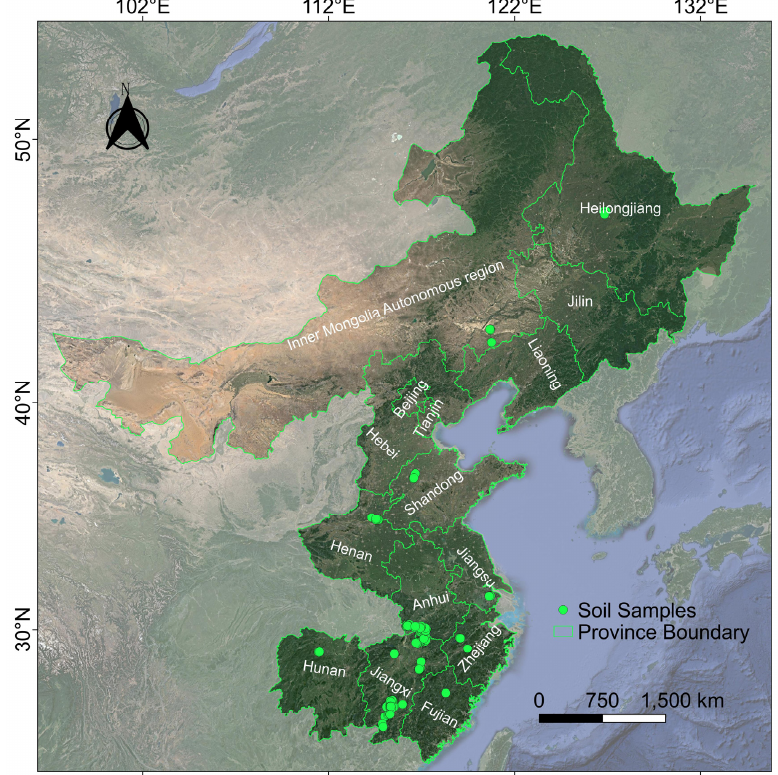
Figure 1. Sampling points distribution. The background data were from